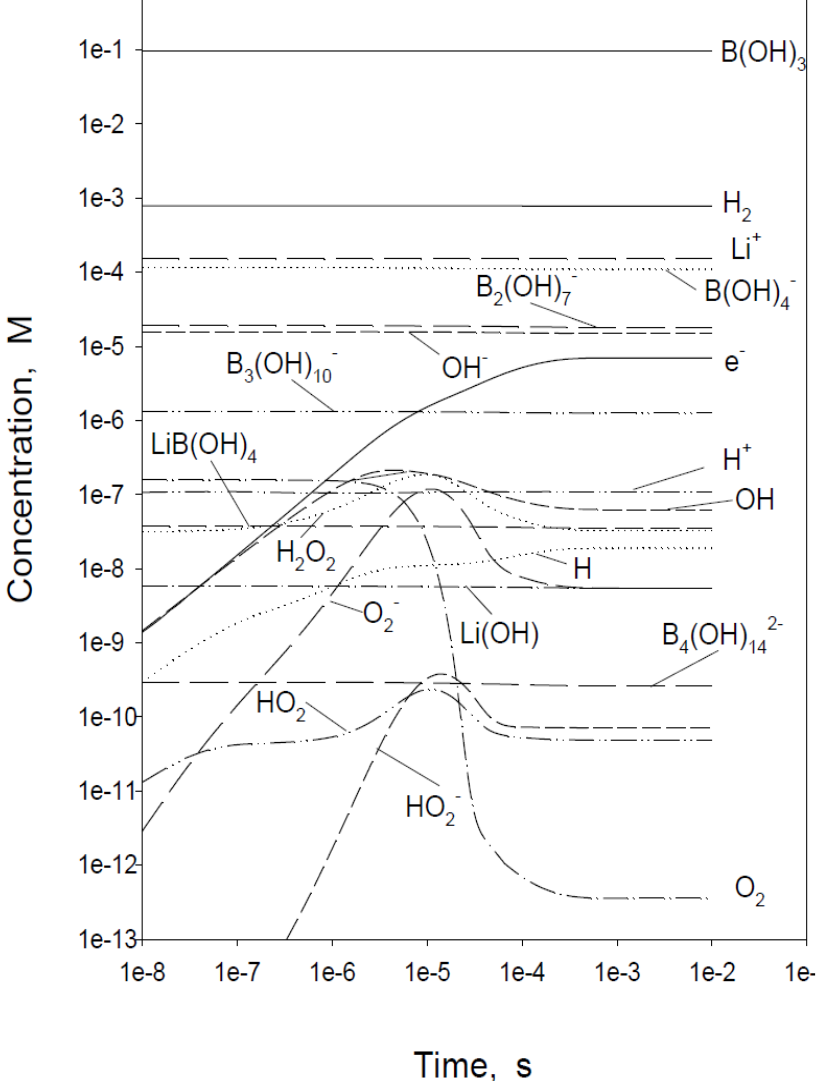
Figure 1. Concentrations of radiolysis and pH control species in the primary coolant of a PWR as a function of time towards achieving a local steady state for C B,T = 1500 ppm, C Li,T = 1.5 ppm, T = 300 ◦ C, [H 2 ] = 25 cm 3 /kg STP (2.23 ppm), Γ n = 1 × 10 20 eV/cm 3 s, and Γ γ = 3 × 10 21 eV/cm 3 s. ©2017 OLI Systems,